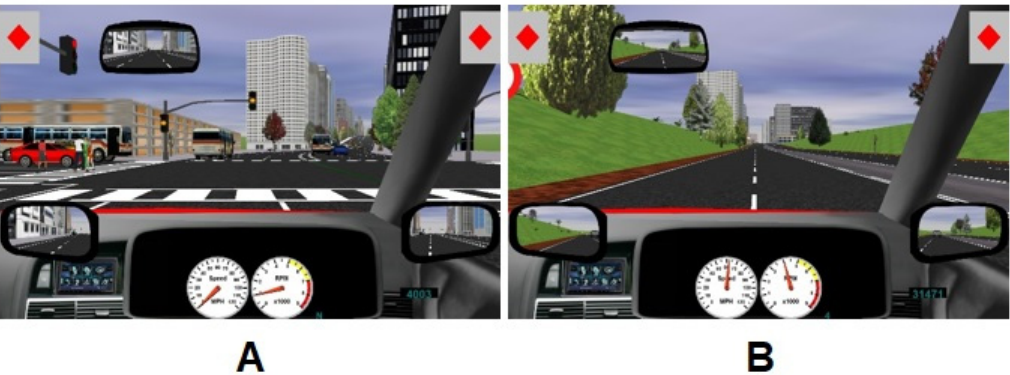
Figure 1. Examples from the STISIM driving test scenario. The STISIM driving test scenario included both city driving scenes ( A ) with a relatively high number of external stimuli (e.g., traffic lights, pedestrians crossing the road and rural roads ( B ) with less external stimuli (e.g., no traffic lights, lower traffic density). On the top left and right of the screen, symbols for the divided attention task are depicted to which subjects had to respond by pressing a button on the steering wheel.